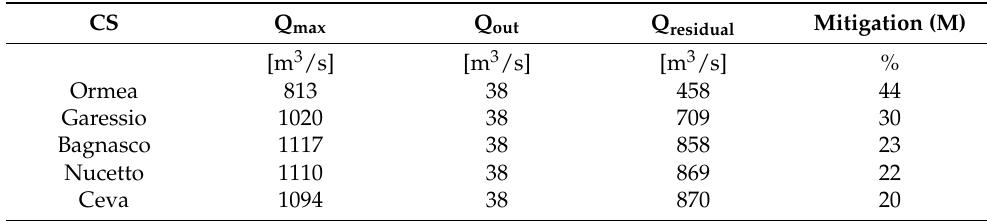
Table 6. The OS for the two dams proposed for the Negrone and Tanarello rivers and their mitigation effect (M) expressed as a percentage; the Q out values for the Negrone and Tanarello dams are 21 m 3 /s and 17 m 3 /s, respectively (thus, a combined 38 m 3 /s).